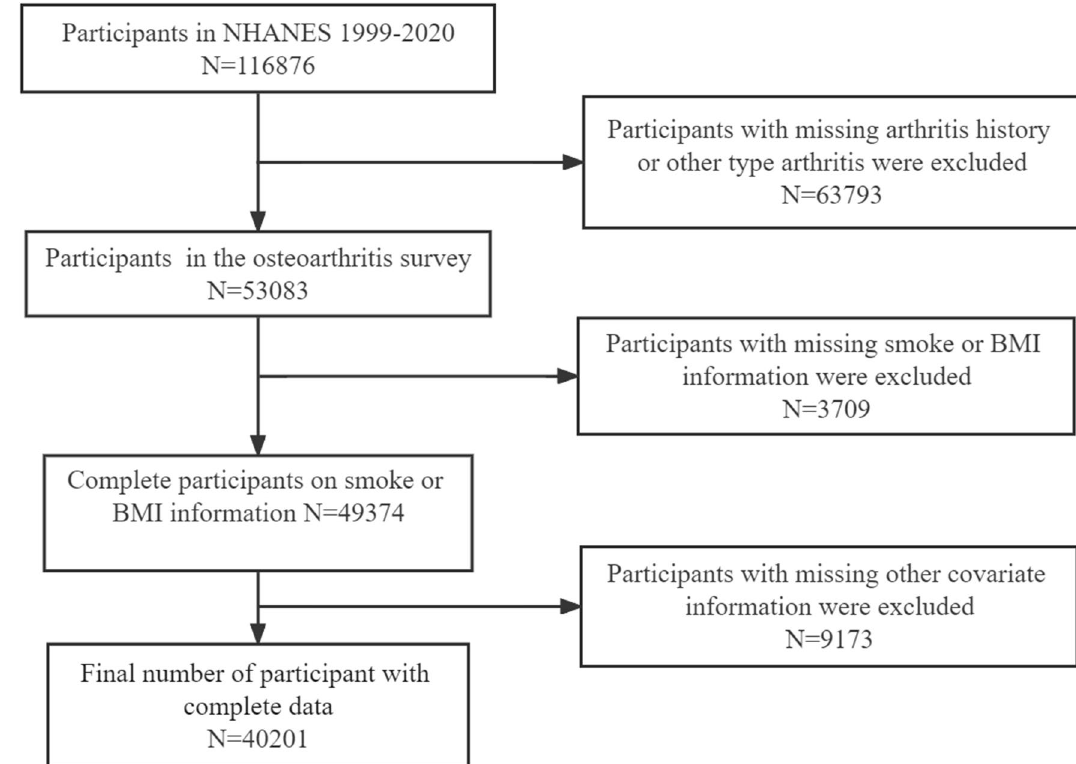
Figure 1. Flowchart of study